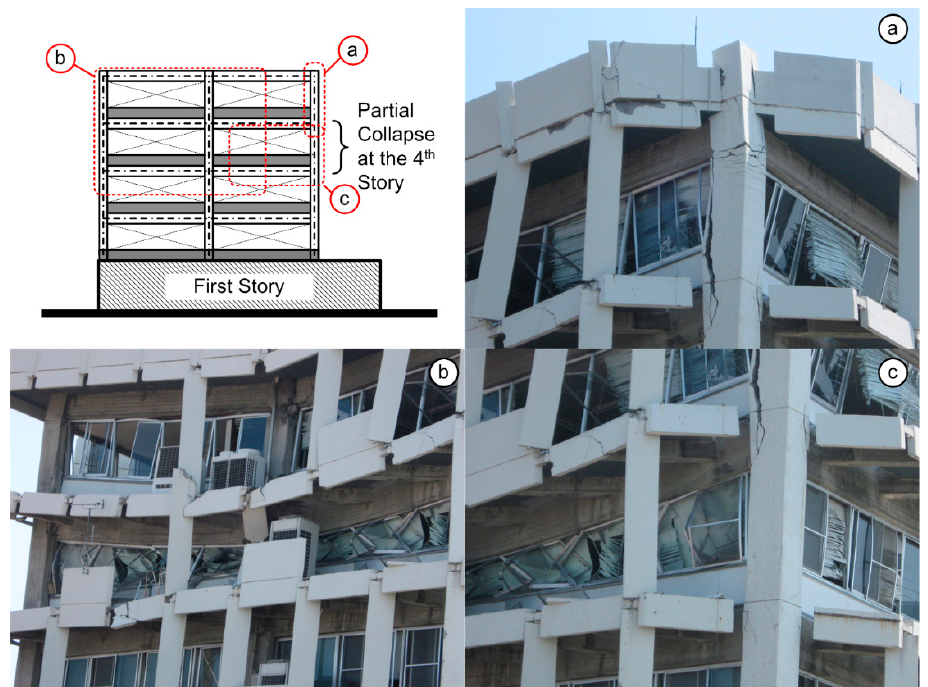
Figure A4. Simplified elevation and photographs of the west elevation. Photographs show ( a ) damage to the corner column on the fifth story, ( b ) partial collapse of the fourth story, ( c ) damage to the corner column on the fourth story.